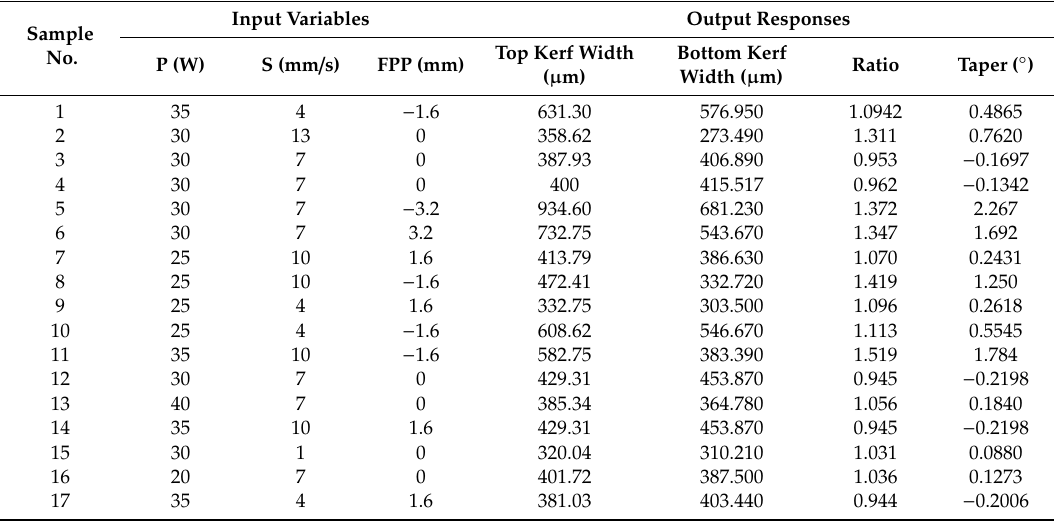
Table 2. Results overview for laser cutting experiments.